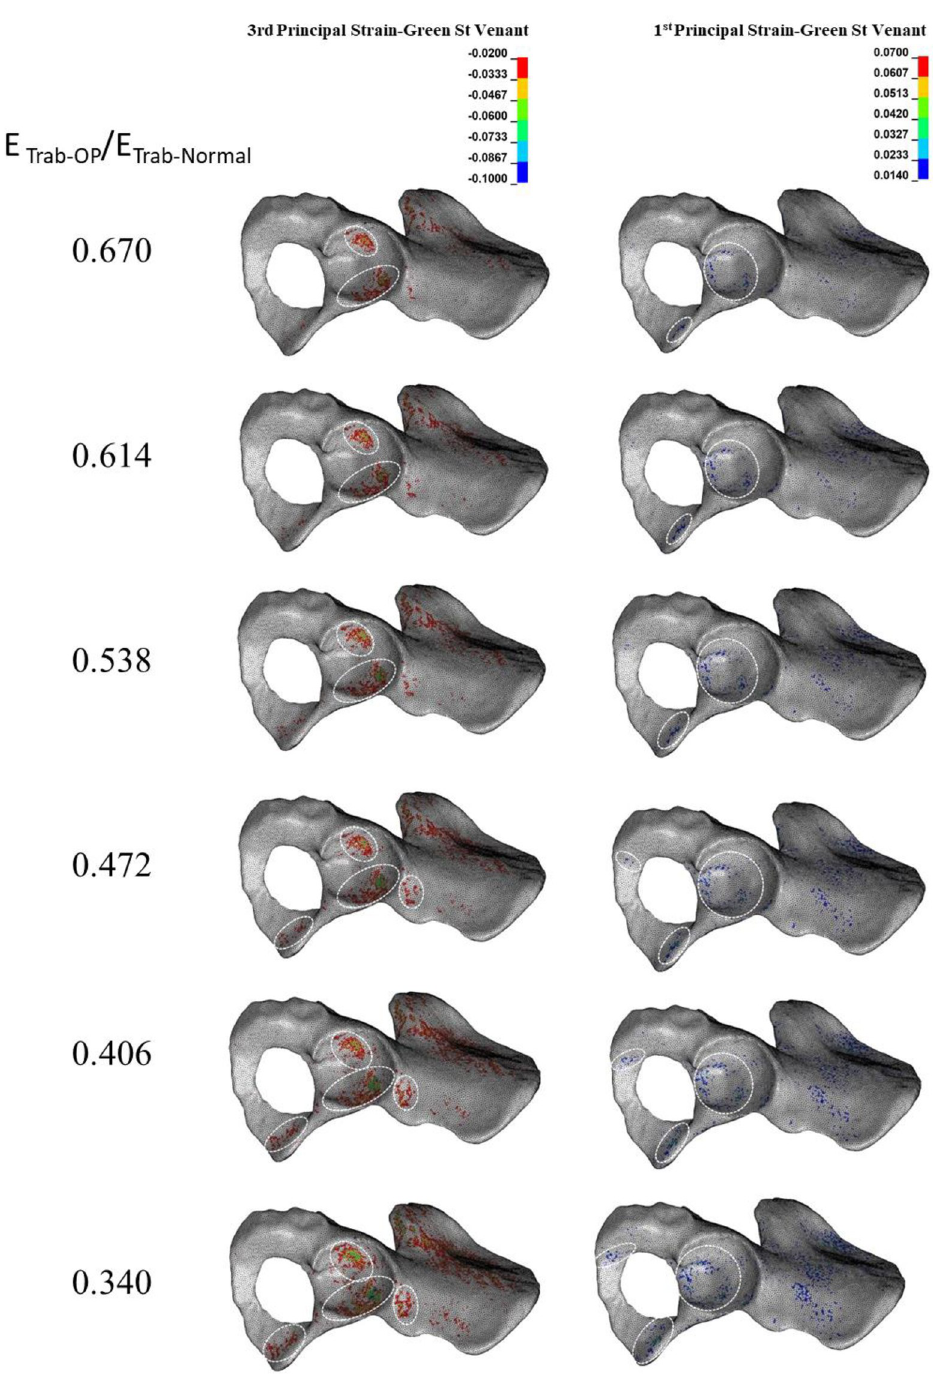
Fig 2. Effect of reduction in trabecular elastic modulus (E Trab ) on the compressive (left column) and tensile (right column) trabecular bone failure . Dashed circles: anatomical landmarks with a high risk of bone failure. E /E from 0.835 to 0.670, the maximum transmitted force decreased by 18.6% Cort-OP Cort-Normal and 23.9% within the hip and sacroiliac joints, respectively (Fig 8A and 8B). However, the maximum force transfer trend in the sacroiliac joint was not so evident in all levels of E